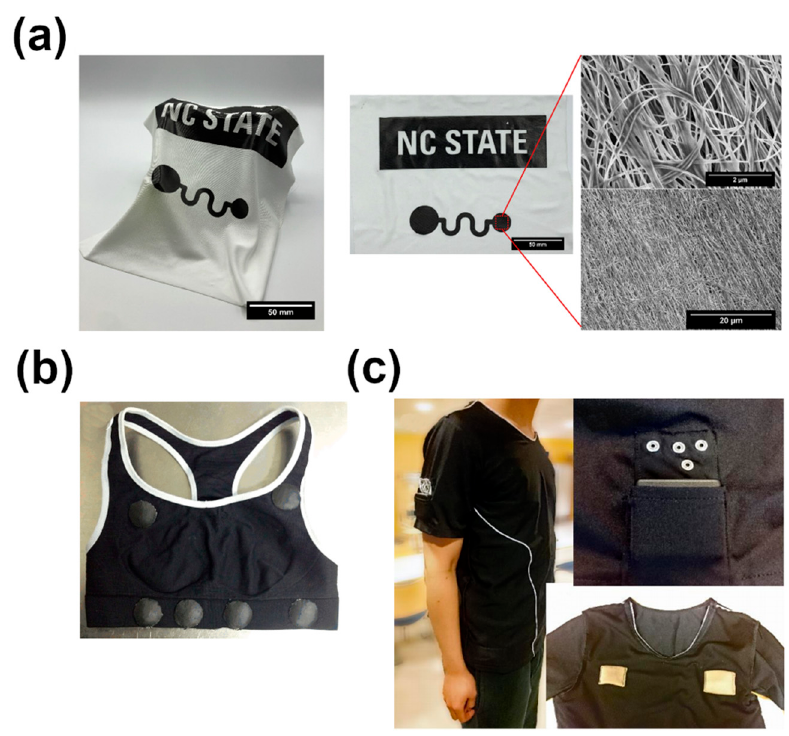
Figure 9. Prototype e-Textiles for ECG measurement: ( a ) t-shirt along with visualization of the microstructure of the material by SEM modified and reproduced with permission from [157], Copy- right Elsevier (2020); ( b ) woman’s smart vest modified and reproduced with permission from [147], Copyright Elsevier (2017); ( c ) smart garment with the indication of the placement of textile electrodes and a pocket for a wearable instrument to collect the data modified and reproduced with permission from [158], Copyright The Authors (2019).